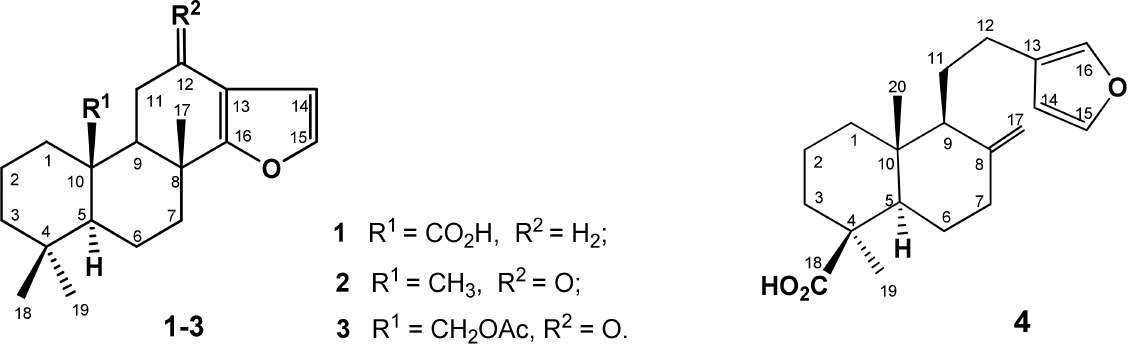
Figure 1. Structures of natural marginatafuran-type isospongian diterpenoids 1 – 3 and lambertianic acid 4